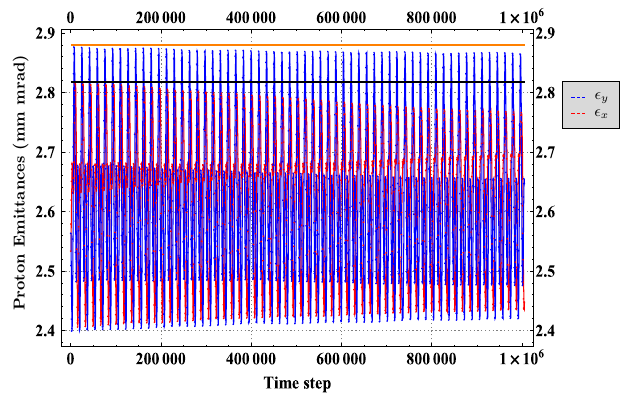
FIG. 19. The transverse emittance of the proton beam cooled bunch of 1 cm radius with a 5 mm electron beam radius in the presence of a stronglongitudinal magnetic field of B ≈ 10 − 3 . The black and orange lines are reference lines for p =p x;y z ϵ and ϵ , x y